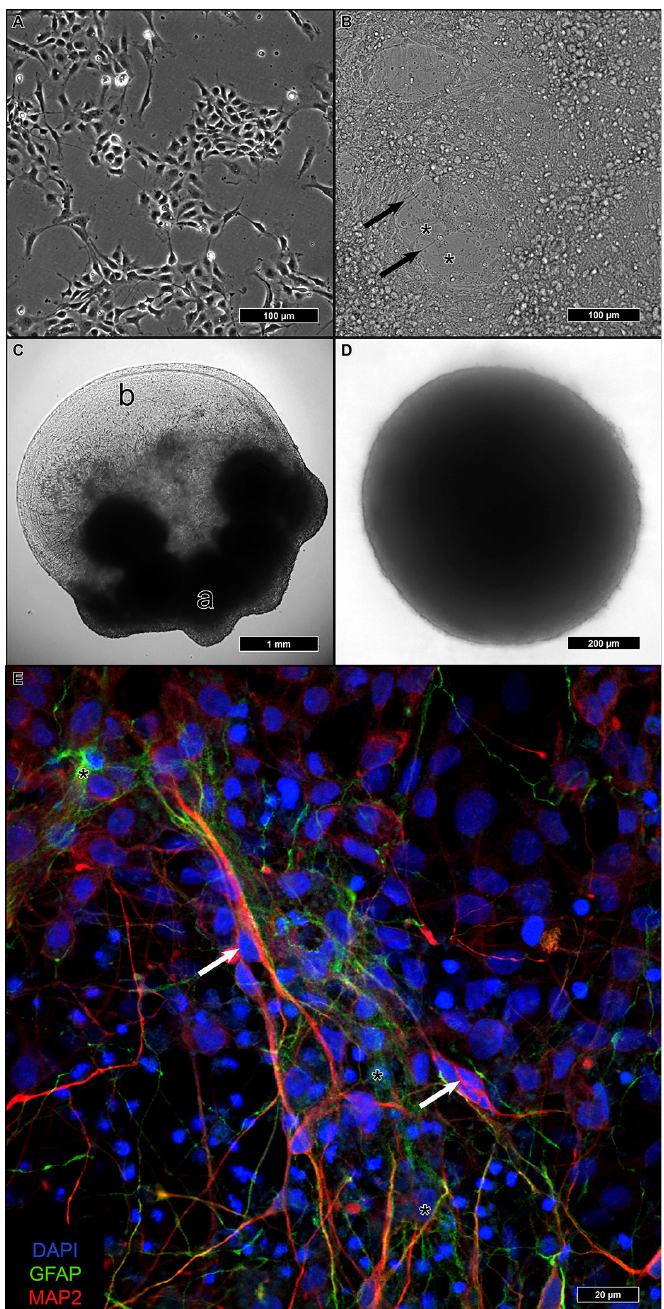
Figure 1. The three di ff erentiation modalities in culture: induced neural stem cells (iNSC) growing adherently as a homogenous monolayer ( A ). After one month of adherent di ff erentiation, neurite spreading cells (arrows) are placed on scattered layers of flat, presumably glial cells (asterisks) ( B ). Neural aggregates embedded in Matrigel, reaching several millimeters in size, kept their original polarity: spheres did not migrate away from their original site and form an apical part (a), while outgrowing neurites formed a dense network in the basal (b) parts of the aggregates ( C ). Neurospheres full of tightly packed cells appeared homogenously with a smooth surface, their size not exceeding 1 mm ( D ). Neurospheres replated on coverslips for outgrowth and incubated for immunofluorescence exhibited microtubule-associated protein 2 (MAP2)-positive neuronal (red, arrows) and glial fibrillary acidic protein (GFAP)-positive astrocytic cells (green, asterisks) in a proportion of roughly 5:1 (neurons: astrocytes) ( E